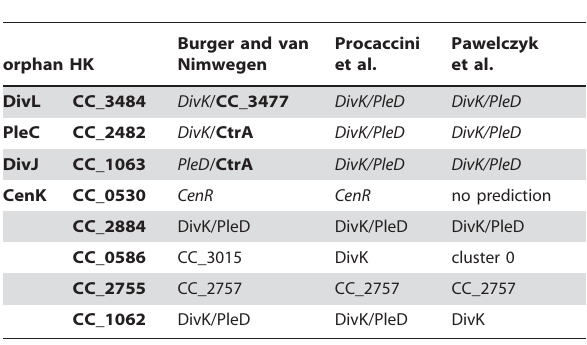
Comparison of response regulator predictions for Caulobacter crecentus histidine kinases. The table shows the predictions of possible response regulators for C. crecentus histidine kinases from different prediction tools. Experimentally validated RRs are highlighted in italic, experimentally disproved interactions in bold and untested partners in roman type.